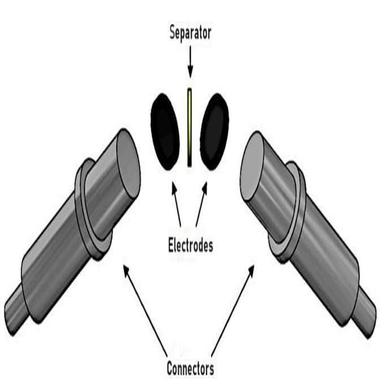
Components of a supercapacitor.